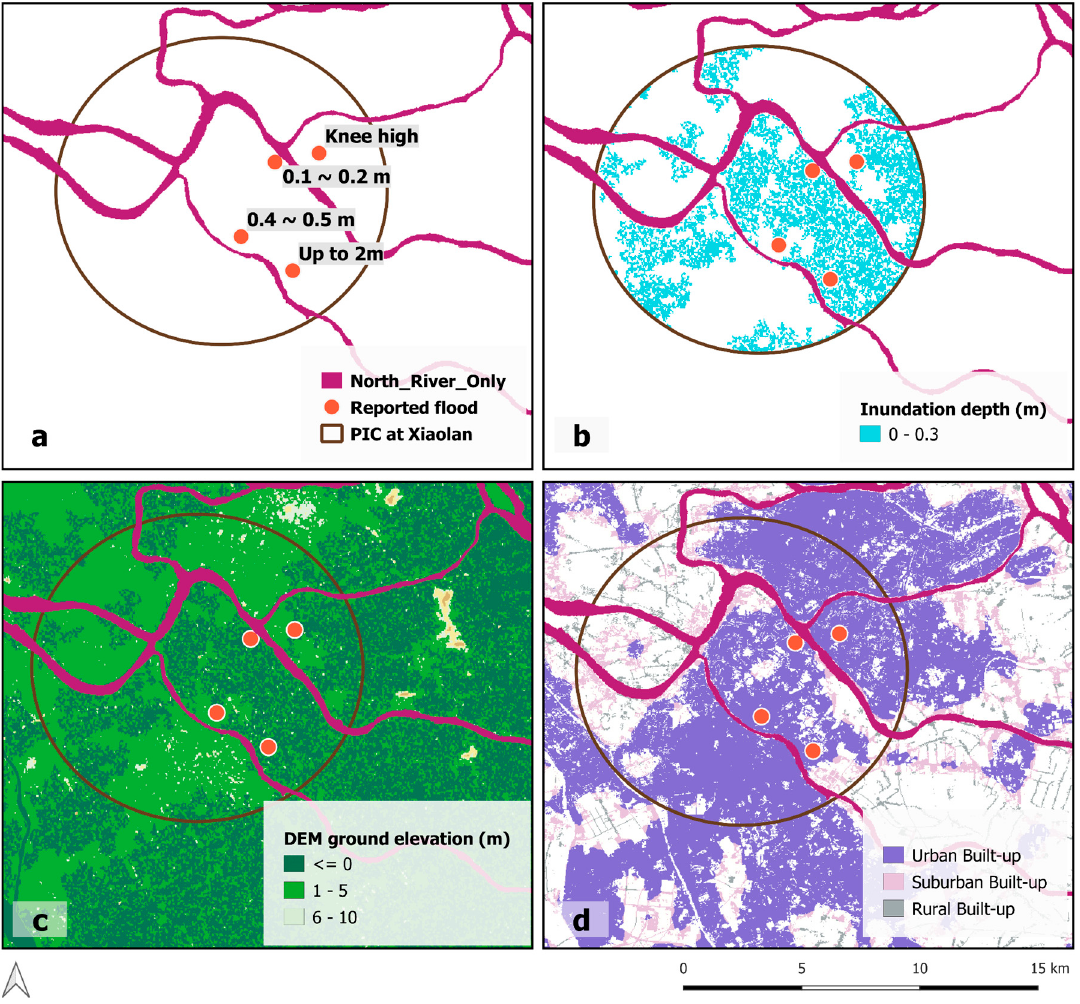
Figure 8. Comparison of the reported and estimated inundation area around Xiaolan station for the 2017 event. ( a ) Reported inundated areas with their corresponding flood depths [35,36], ( b ) calculated inundation area shown in blue shaded area within the potential inundation circular (PIC), with a radius of 7 km, ( c ) ground elevations from Shuttle Radar Topography Mission (SRTM) DEM, and ( d ) selected land categories based on the 2014 dataset from the NYU Urban Expansion Atlas.